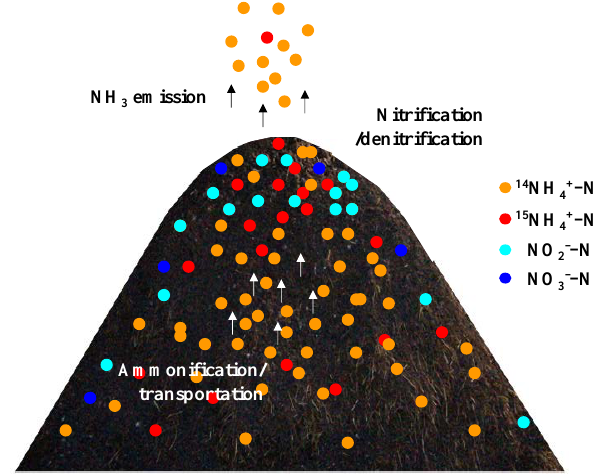
Figure 5. Summary of the events between the pile